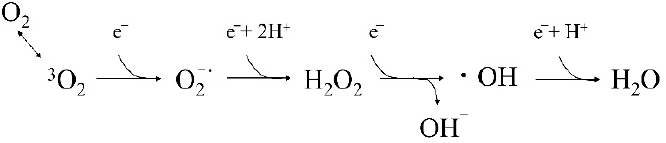
Figure 1. Redox reactions and reactive oxygen species (ROS) in vivo. Triplet oxygen ( 3 O 2 ) is reduced (one-electron reduction) and converted to superoxide anion (O 2 −· ). The O 2 − is then reduced by one more electron, and two H + are added, leading to the formation of hydrogen peroxide (H 2 O 2 ). When H 2 O 2 is further reduced by one more electron, the bond between the O atoms can no longer exist stably, and the bond breaks to form the hydroxyl radical ( • OH) and hydroxide ion (OH − ). Finally, • OH is reduced by one more electron, and one H + is added, forming H 1 O 2 O. Singlet oxygen ( 2 ) is generated by an energy transition with 3 O 2